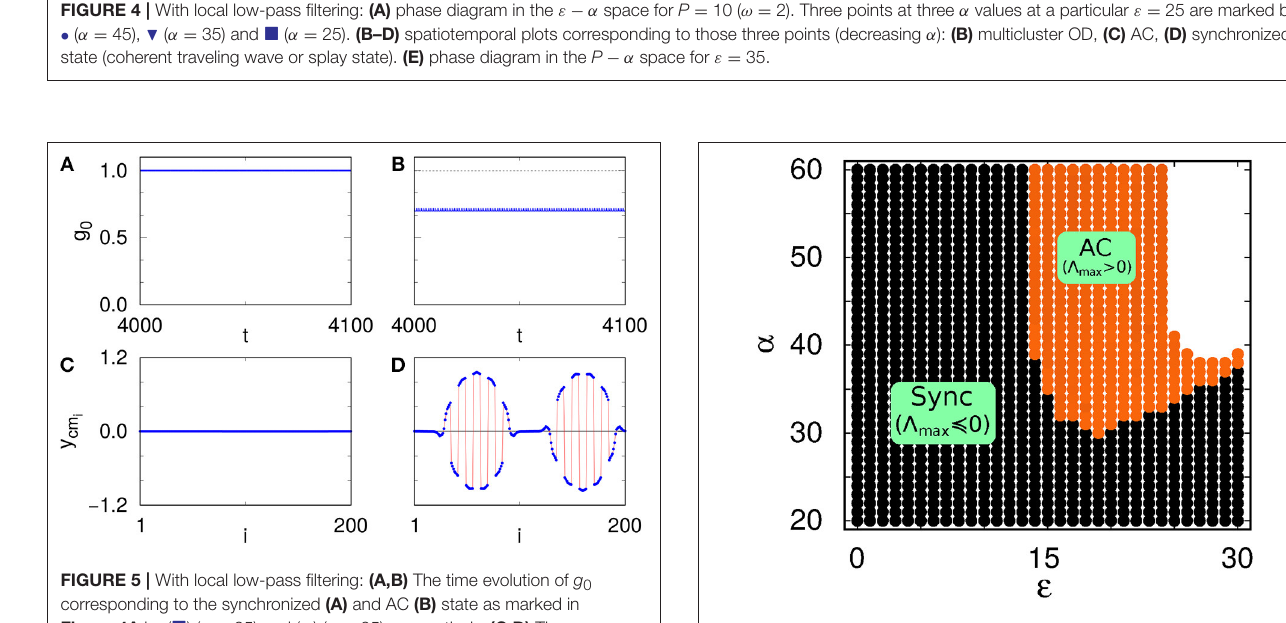
FIGURE 6 | With local low-pass filtering: Phase diagram of the periodic solutions (Sync and AC) in ε synchronized region (black), at each point, the largest real part of the Floquet exponents ( 3 max ) is negative (for the Goldstone mode it is approximately equal to zero). For the AC region (orange) at each point it is greater than zero (i.e., 3 max > 0). Other parameters are P